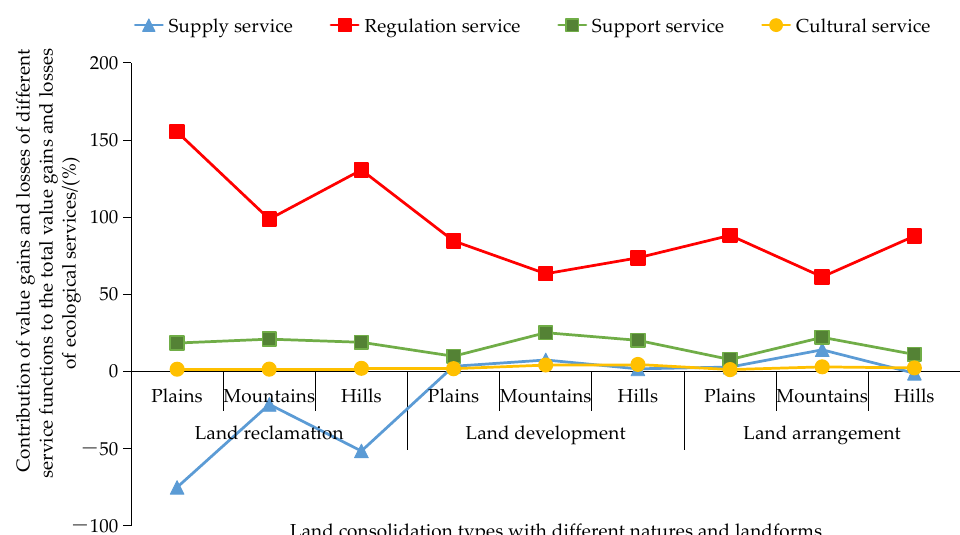
Figure 8. The ratio of value gains or losses for different service functions to total value gains and losses in typical land consolidation project areas in Hubei province.